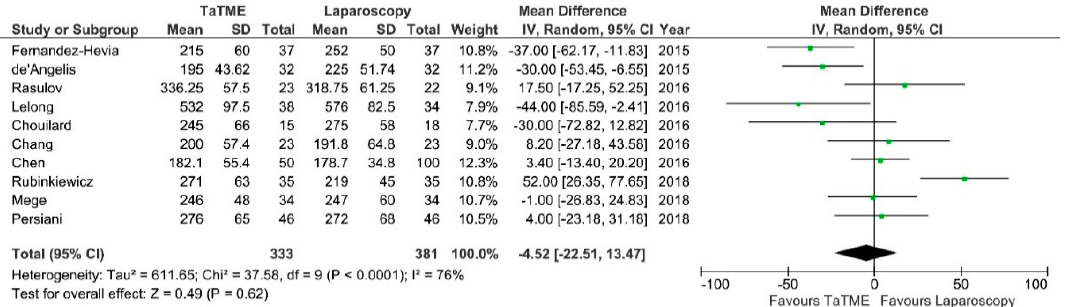
Figure 5. Operative time. CI—Confidence Interval; df—degrees of freedom, M-H—Mantel-Haenszel test. WMD and RR are presented on the graphs as squares, and overall WMD and RR is presented as diamond.